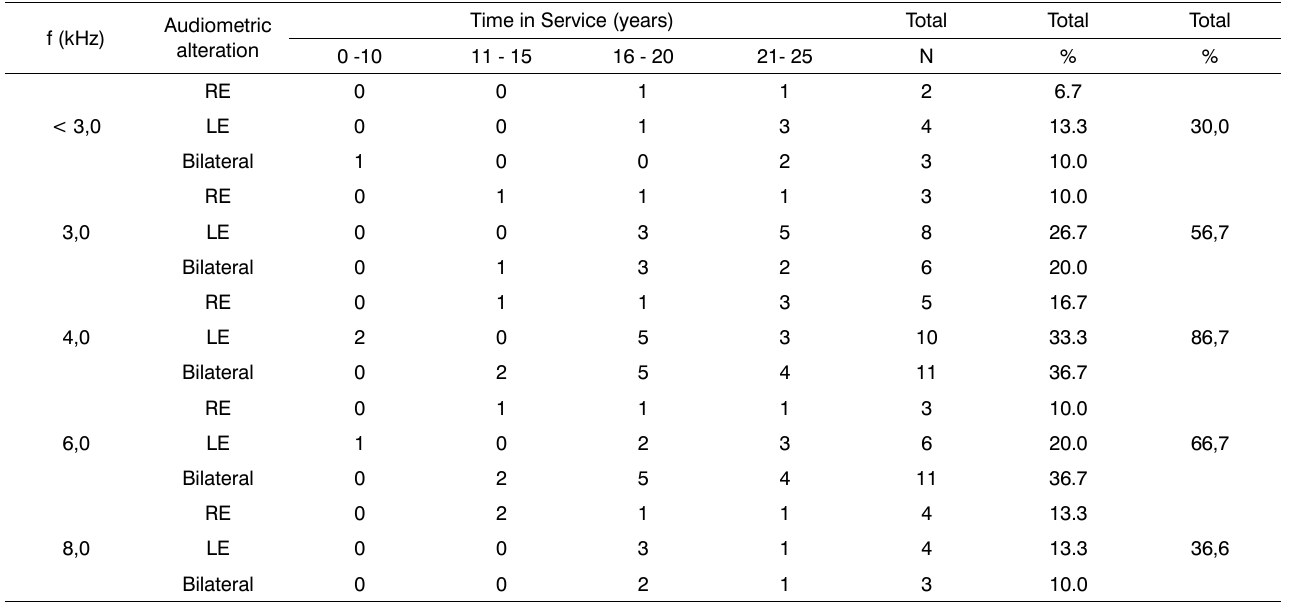
Table 3. Distribution of the audiometric alteration measures in a sample of 30 officers from the police force population, unilateral RE, unilateral LE and bilateral, considering the range of time spent in the service.